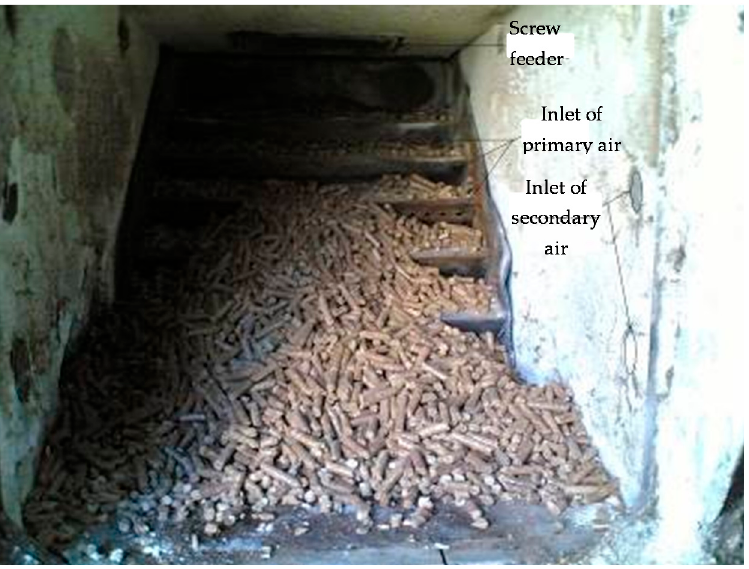
Figure 9. Filling of BIO System burner with pellets from almond tree.